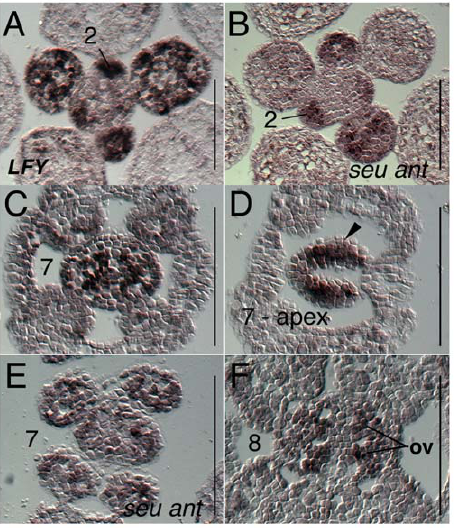
Figure 10. Results of insitu hybridization with EMS antisense probe. Numbers indicate floral stages. All panels show transverse (cross sectional) tissue orientation. ov - ovule; Scale bars in all panels are 100 microns. All panels are Col-0 wild type tissue.